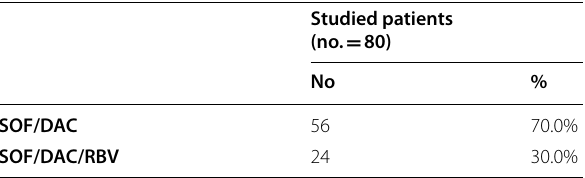
Table 3 Descriptive analysis of different DAAs treatment regimens received by the studied cases